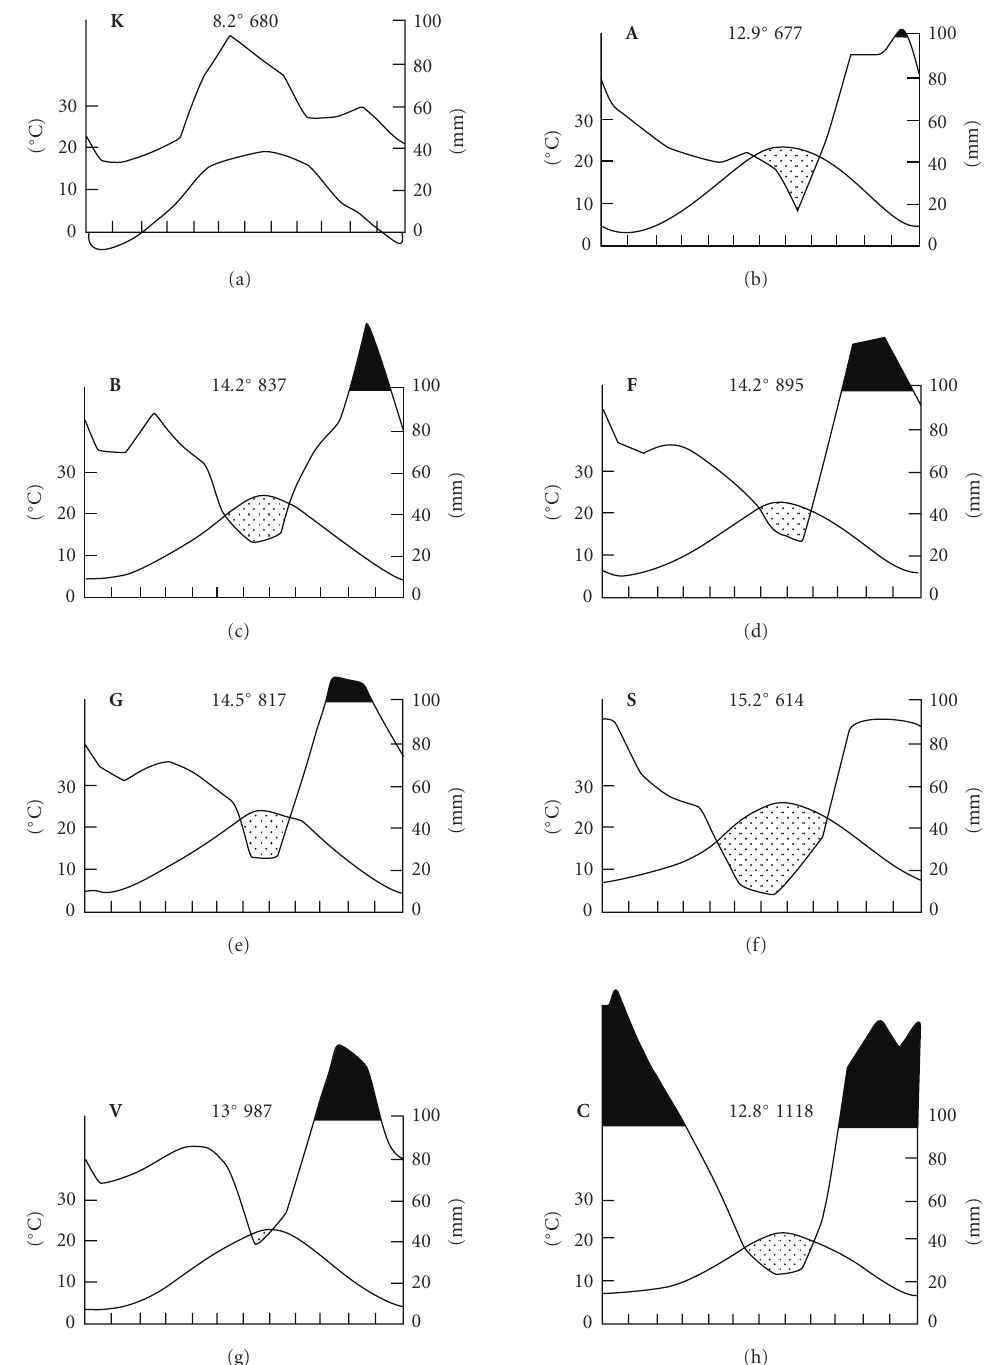
Figure 7: Climate characteristics of the eight Bhanja virus areas in Europe: climadiagrams sensu Walter (monthly course of mean air temperature and precipitation; mean annual temperature and mean total